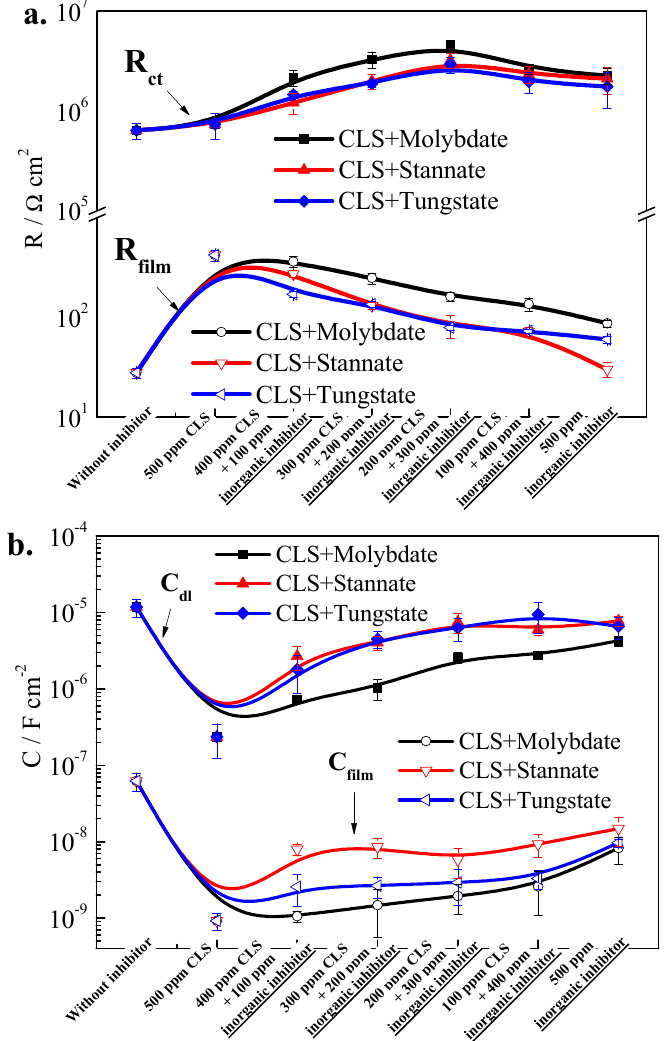
Figure 7. Electrochemical parameters of EIS; ( a ) R ct and R film ; ( b ) C dl and C film .